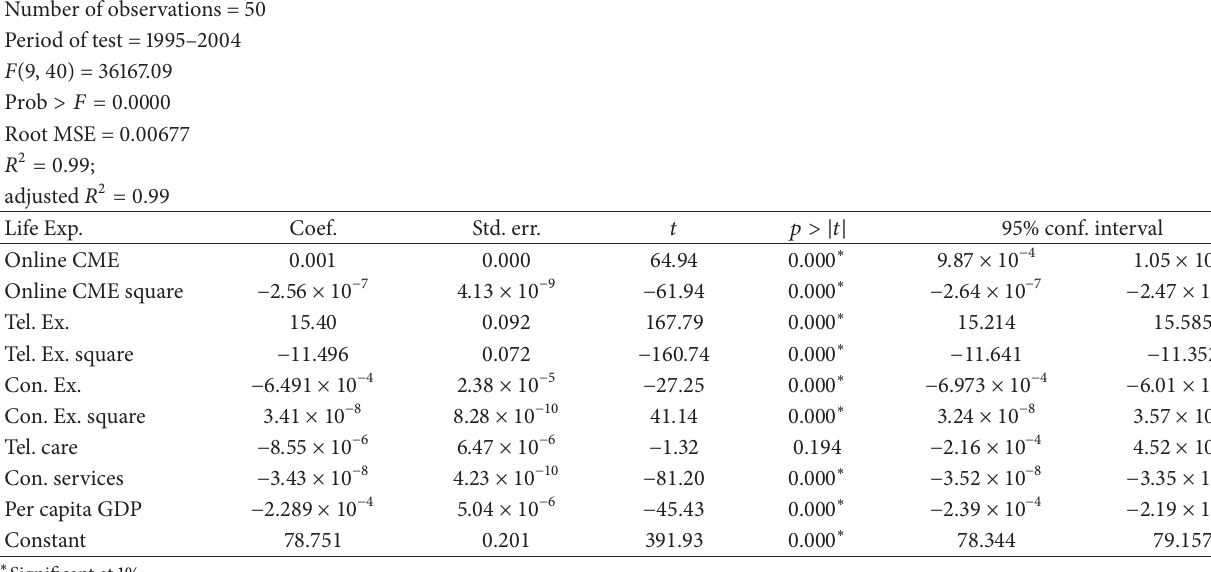
Table 3: Regressions of life expectancy at birth on selected